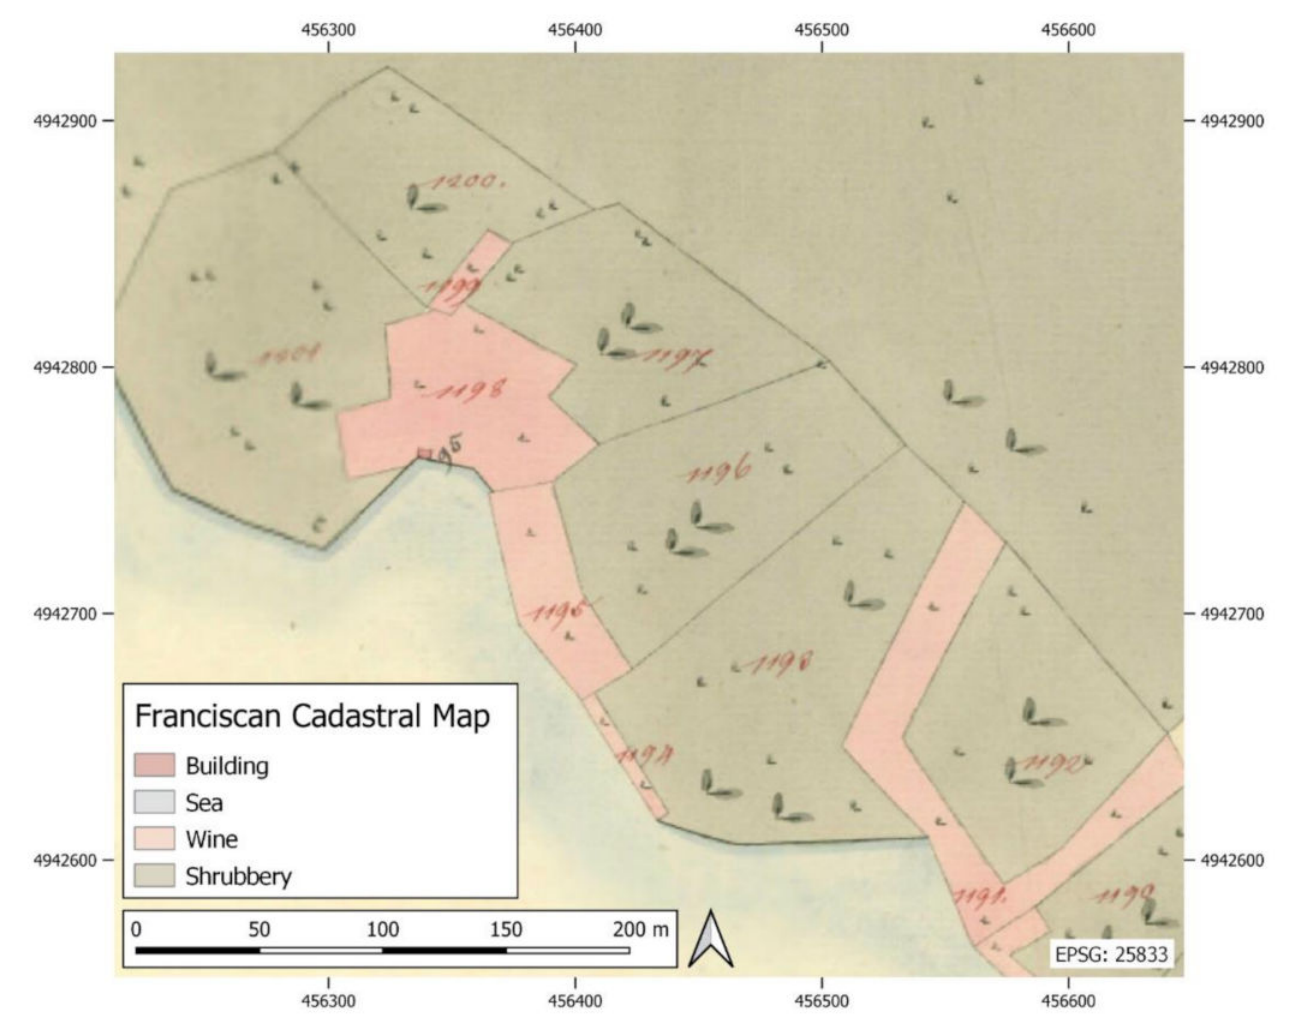
Figure 5. 1821 Franciscan Cadastral Map showing the case study area (source: Archivio di Stato di Trieste—Catasto franceschino/Distretto di Cherso/Comune di Punta Croce/mappa XVI, unit à archivistica 383 b